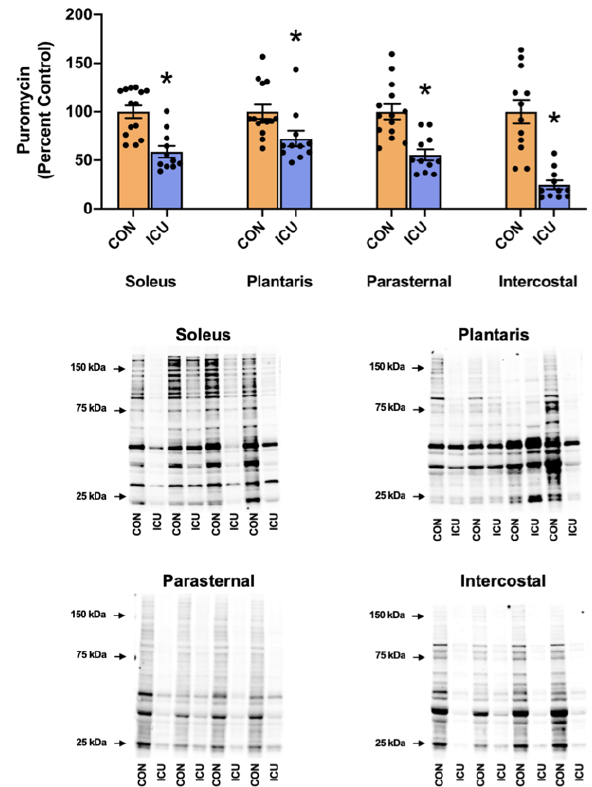
Figure 3. Muscle protein synthesis. Protein expression of puromycin incorporation into the soleus, plantaris, parasternal, and intercostal muscles of control, non-anesthetized, non-ventilated rats (CON), and rats that underwent 12 h of controlled mechanical ventilation (ICU). Representative Western blots are shown below the graph. All protein concentrations were normalized to total protein. Data are presented as mean ± SEM. * significantly different vs. CON ( p < 0.05).